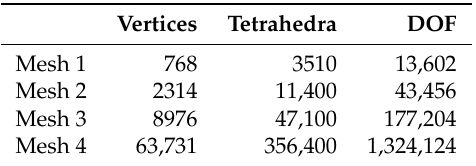
Table 1. The number of vertices, tetrahedra and degrees of freedom (DOF) of fluid–structure linear system for each mesh. Vertices Tetrahedra DOF Mesh 1 768 3510 13,602 Mesh 2 2314 1,324,124